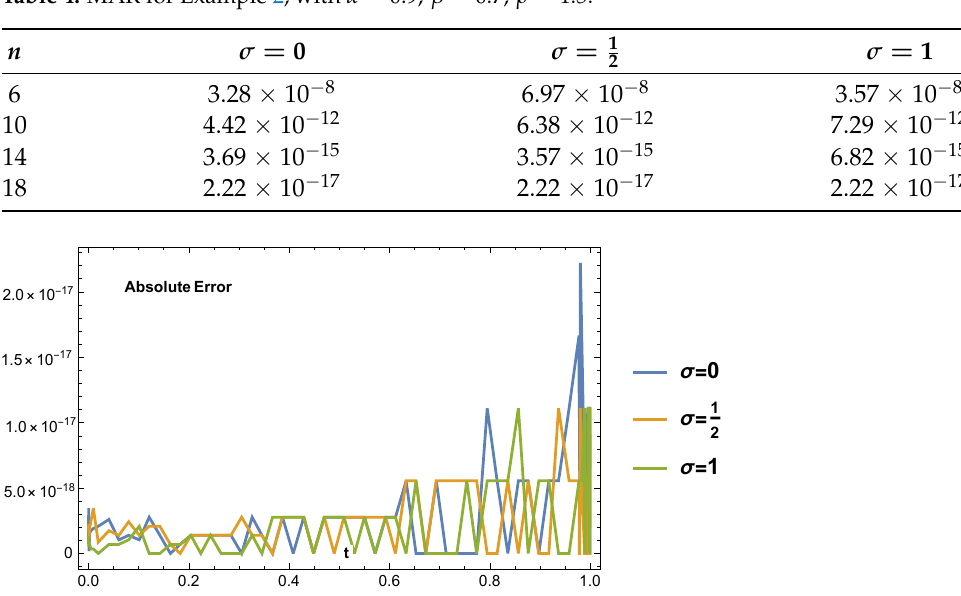
Table 4. MAR for Example 2, with α = 0.9, β = 0.7, ρ = 1.5.